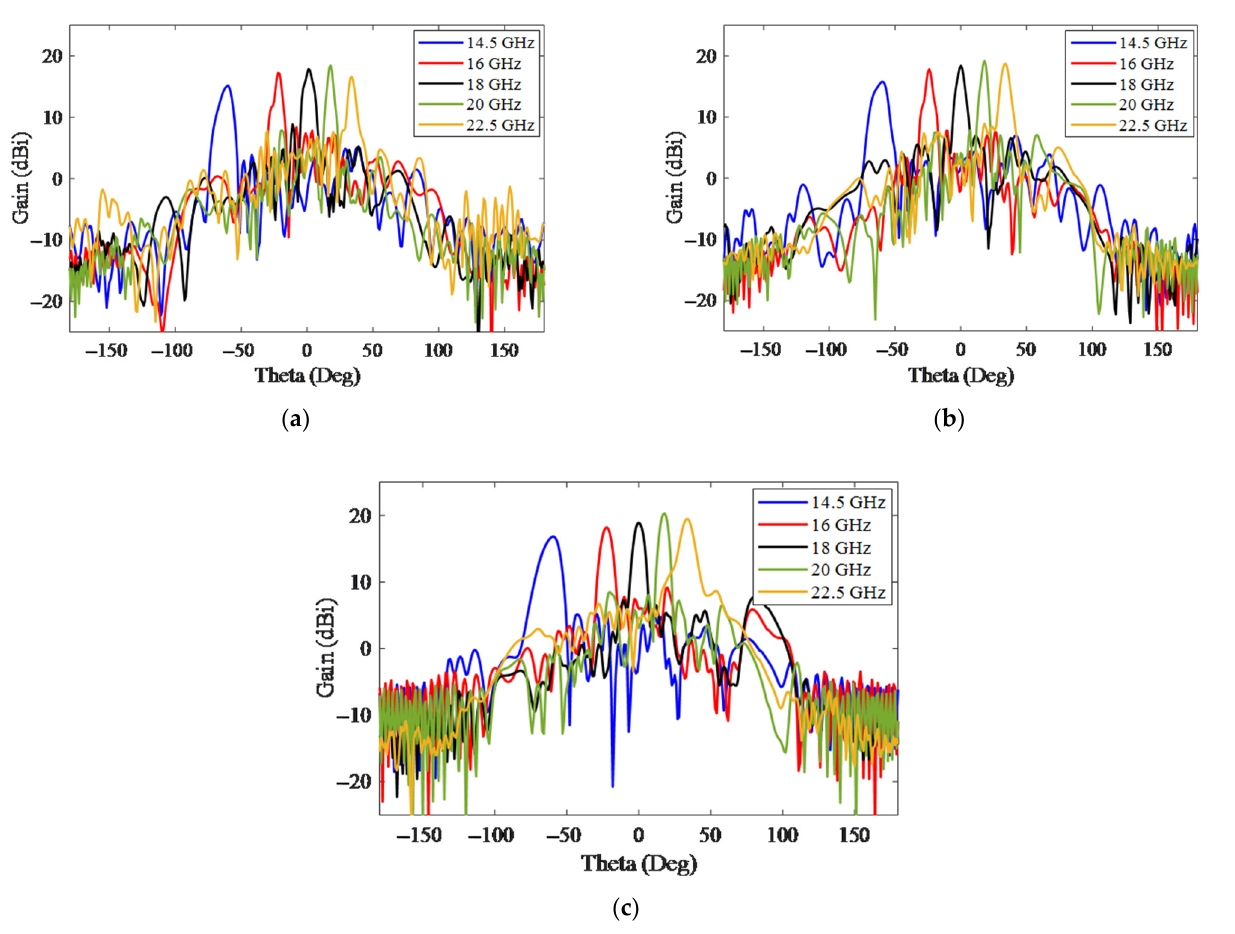
Figure 15. The measured gain of the 2D-MBA in five frequencies for different beam port excitations: ( a ) port 1, ( b ) port 2, and ( c ) port 3.